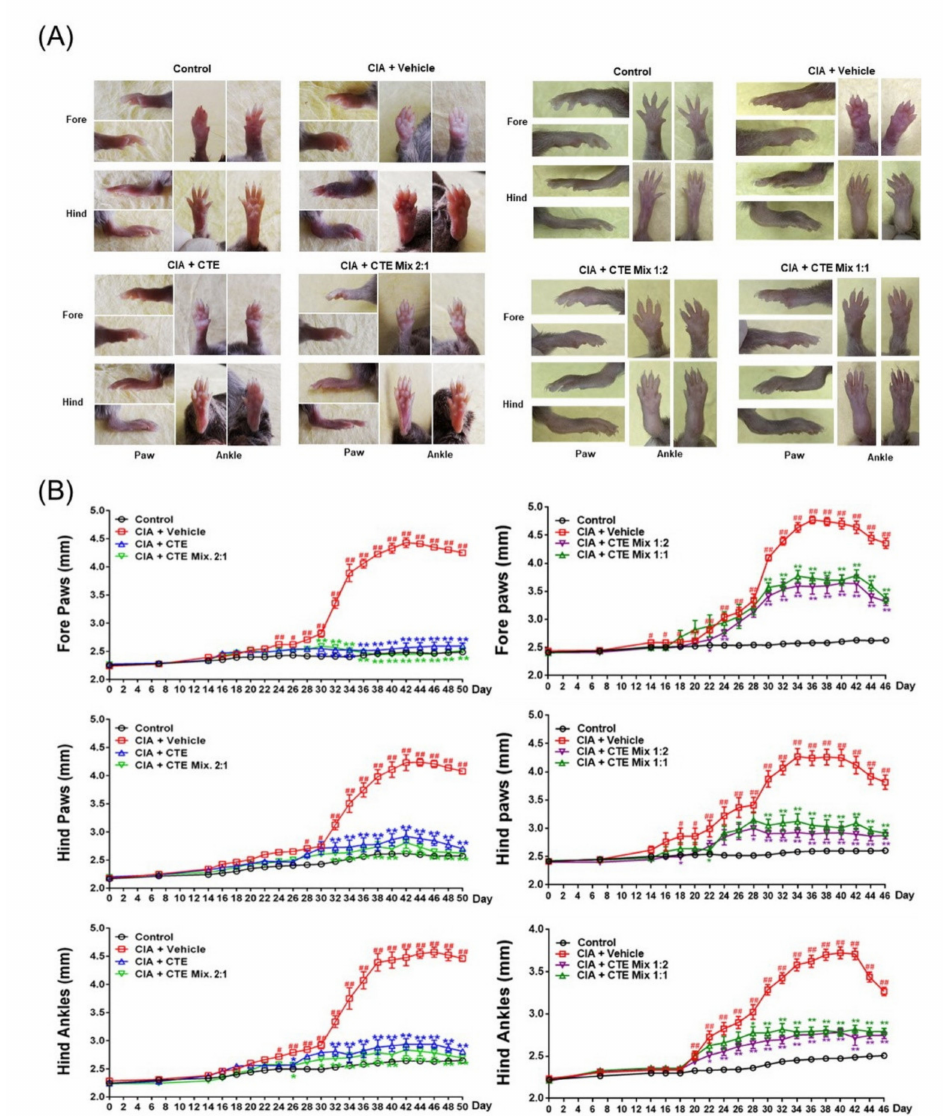
Figure 4. Effect of CTE and CTE mix on arthritis symptoms. ( A ) The control group and vehicle group were orally administered physiological saline. In the CTE group, only CTE was administered orally, while in the CTE/SKE combination groups, these extracts were mixed at the respective concentrations of 2:1, 1:2, and 1:1 and administered orally. Joint swelling was then confirmed (control vs. p < 0.01; vehicle vs. * p < 0.05, ** p < 0.01; n = 5). ( B ) The control group and vehicle group were